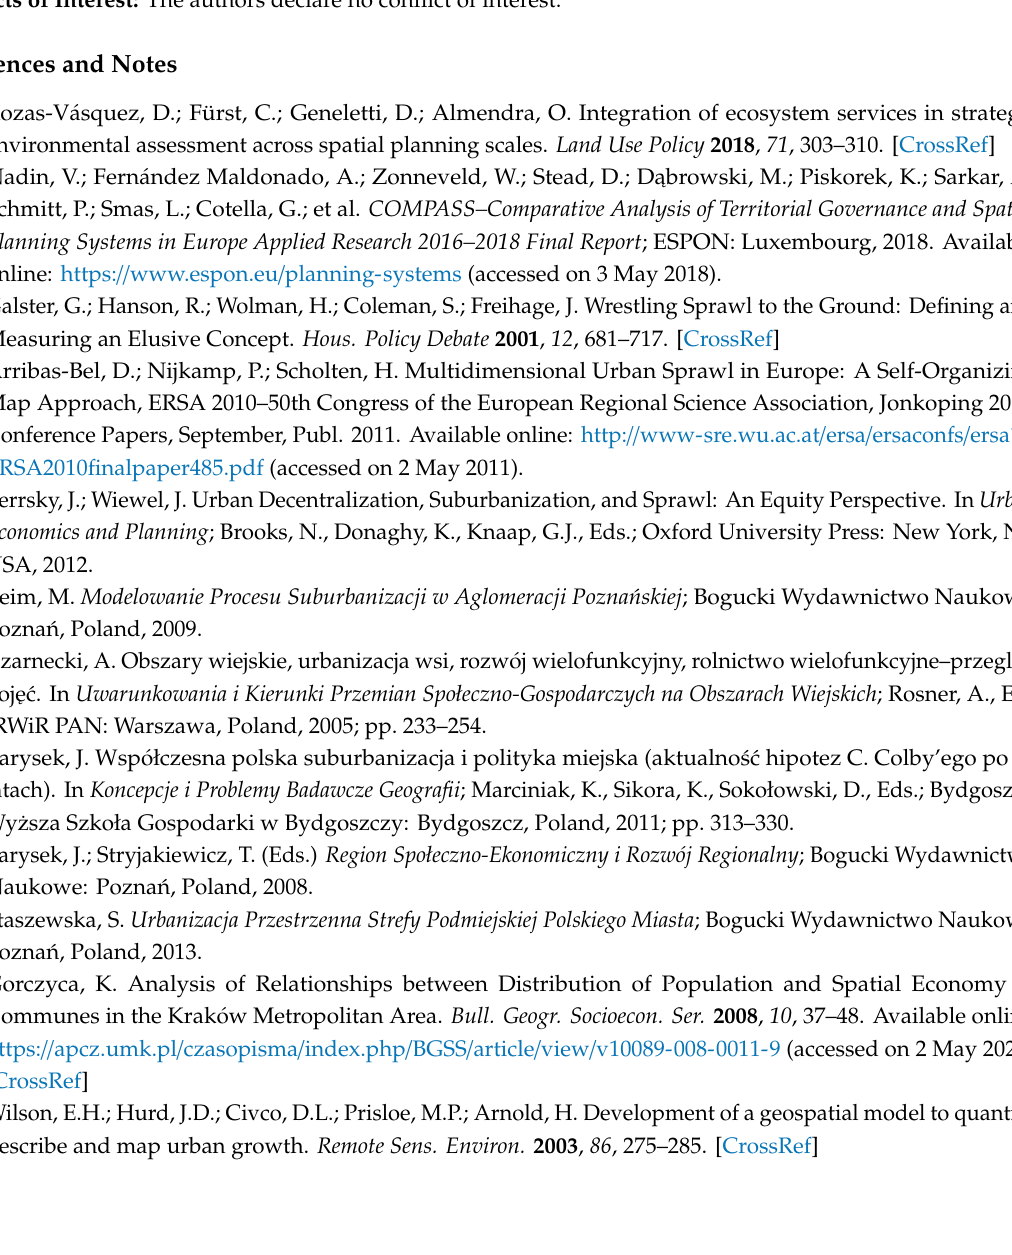
Table S1: Detailed identification of phenomena, conditions, causes and related costs of spatial chaos. Table S2: Detailed list of the spatial chaos